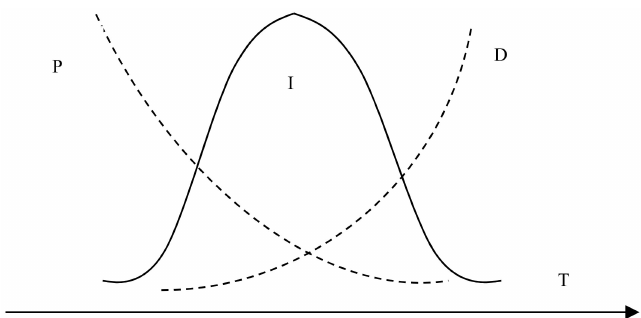
Figure 5. The relationship between nucleation rate and temperature.